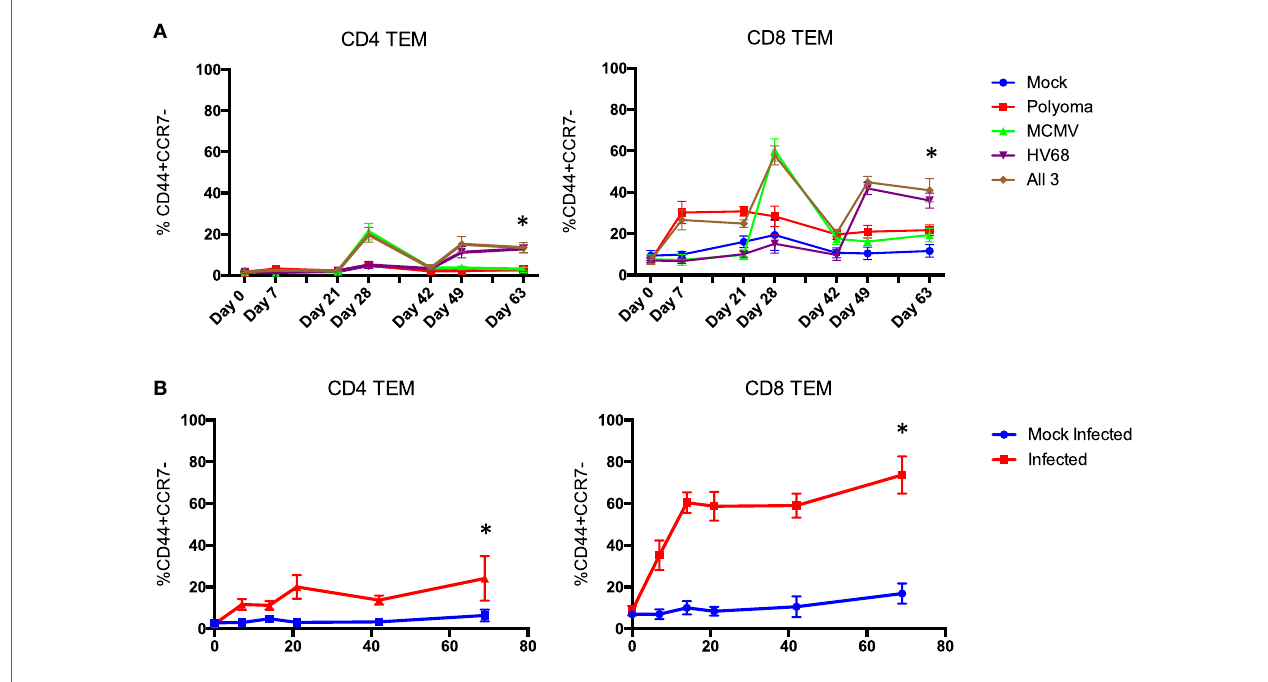
FigUre 3 | Time course of the change in peripheral blood phenotype in C57BL/6 mice following infection with polyomavirus (PyV), murine cytomegalovirus (mCMV), and HV68. Sequential (a) and simultaneous (B) infections with multiple viruses result in a significant and sustained increase in TEM cells in both the CD4 and CD8 T cell compartments compared with mice that received mock infections ( n = 10 per group, p < 0.001 calculated using two-way